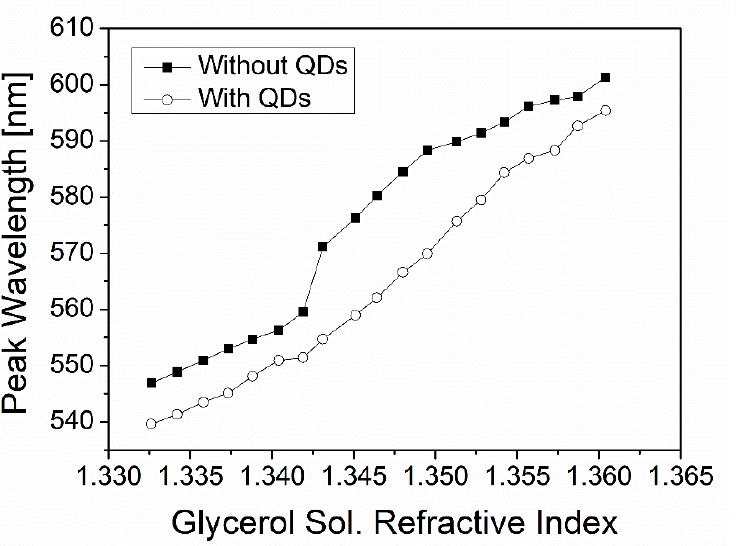
Figure 5. A plasmonic peak versus a local refractive index (glycerol solution index) without or with QDs adsorbed to the plasmonic metal surface. QDs’ adsorption pulls down the peak wavelengths that the y-axis represents. The x-axis denotes the glycerol solution refractive index measured by an Abbe refractometer at all concentrations.